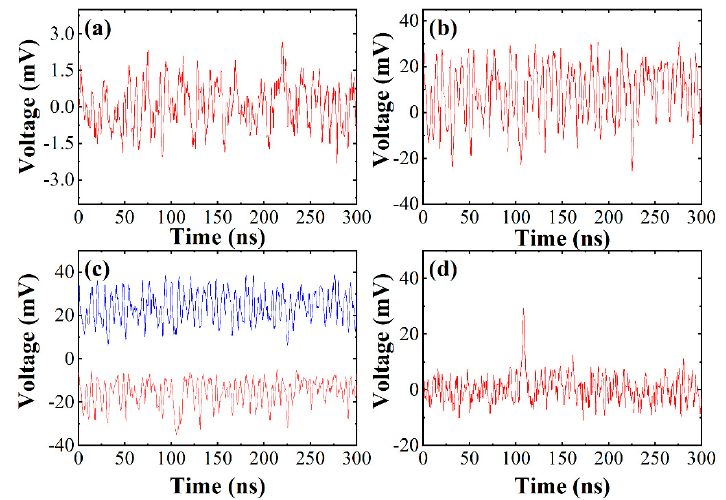
Figure 3. ( a ) Signal collected in a single period, ( b ) signal superposed in 50 periods, ( c ) signals after superposition of positive and negative separately, ( d ) signal after processing.